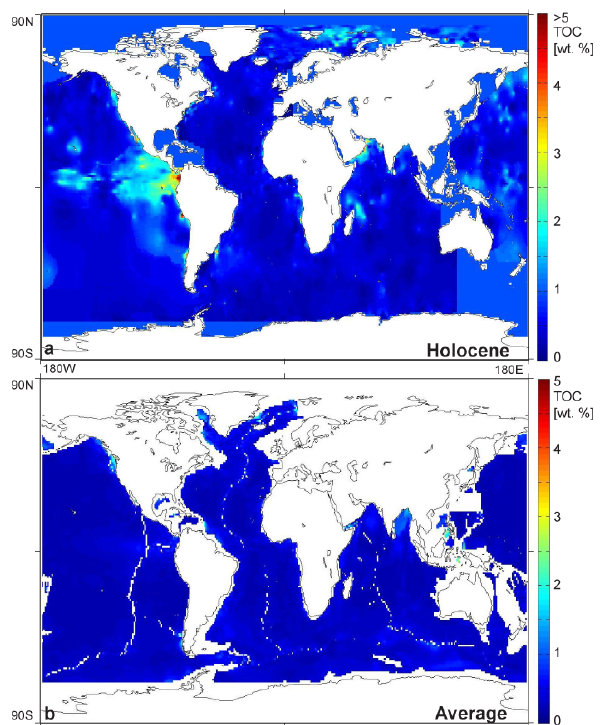
Fig. 3. Distribution maps of the particulate organic carbon during the Holocene, and averaged over geological times, based on Ap- proaches #1 and #2 presented in this work (see Sect. 3.2 for details).